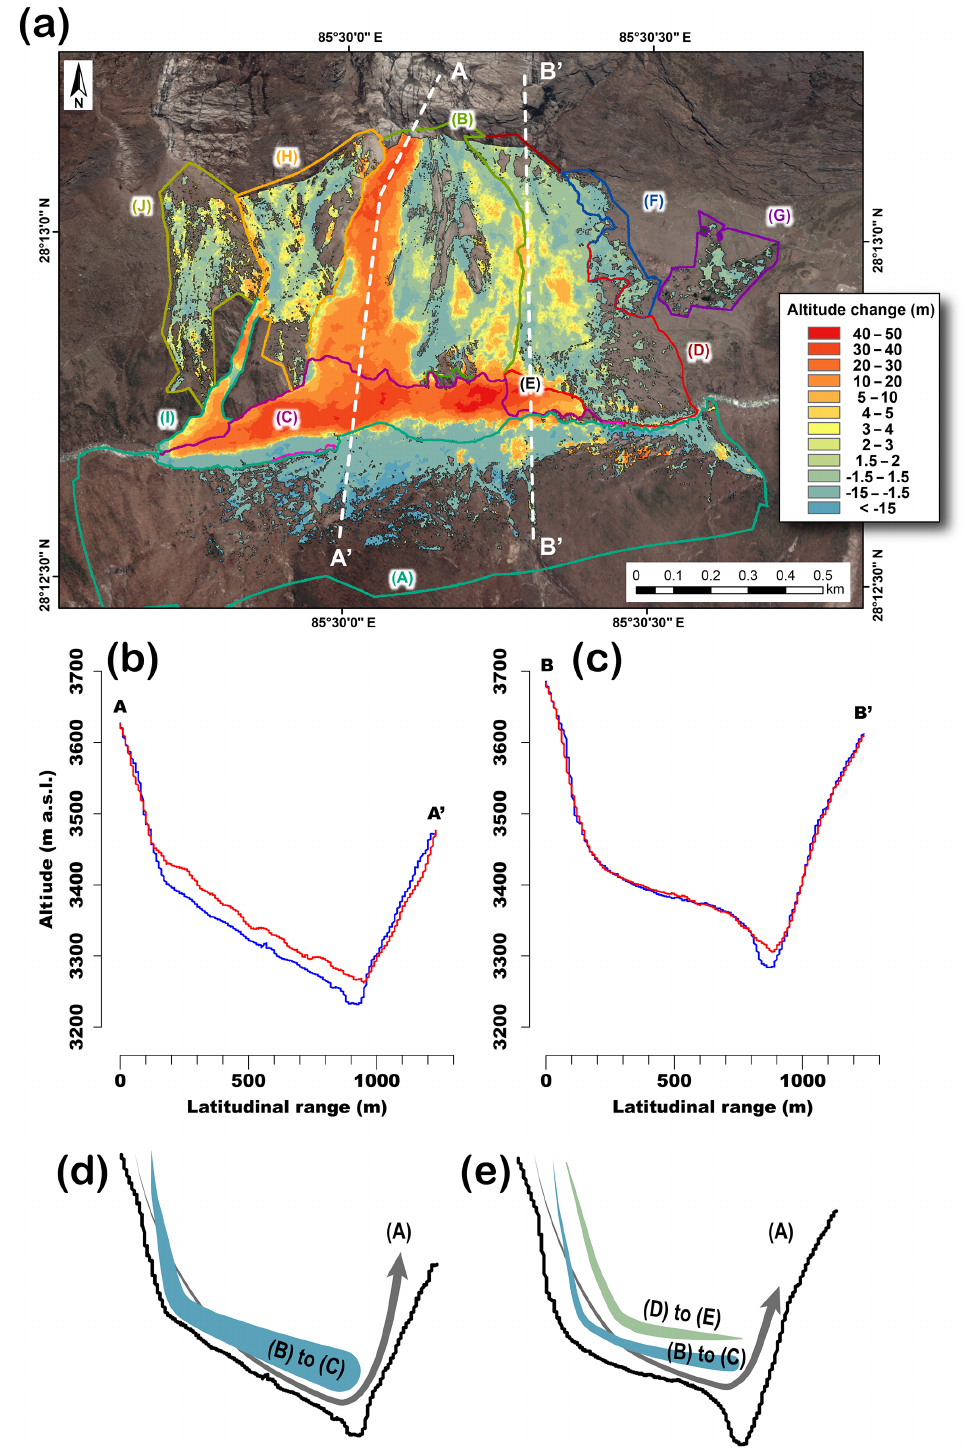
Figure 7. (a) Estimation of the sediment volume from the altitude difference between pre-event ALOS World 3D DSM and post-event WV-3 DSM. Vertical profiles along (b) A–A (cid:48) and (c) B–B (cid:48) are used, respectively, for the schematic illustrations of avalanche sequences in panels (d) and (e)